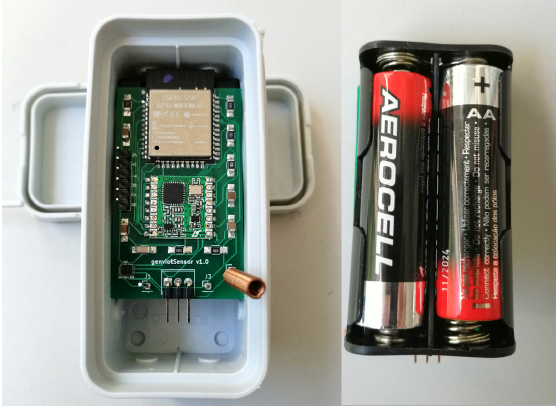
Figure 2. Smart Node.